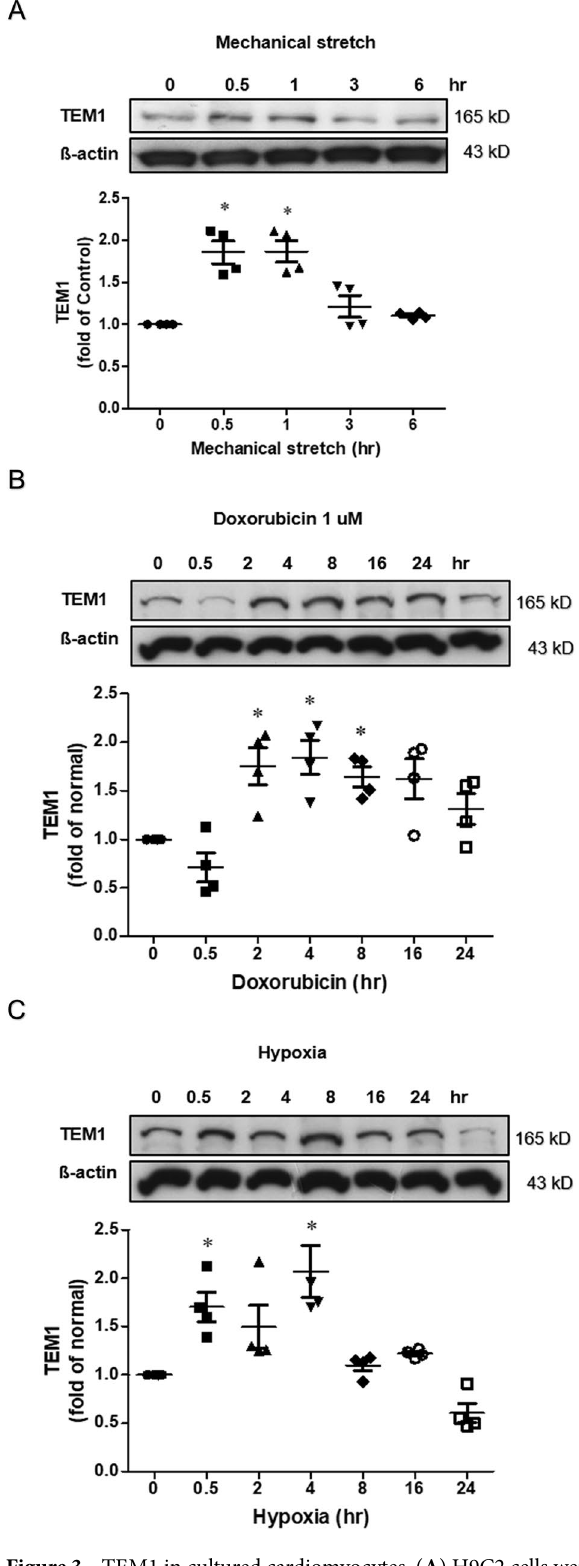
Figure 3. TEM1 in cultured cardiomyocytes. ( A ) H9C2 cells were subjected to mechanical stretch for 6 h. ( B ) H9C2 cells received doxorubicin (1 µM) treatment for 24 h. ( C ) H9C2 cells were exposed to hypoxia incubator prefilled with 1% oxygen for 24 h. The expression levels were analyzed by western blot and expressed as a ratio of baseline before stress (n = 4). *p < 0.05, **p < 0.01 and ***p < 0.001 compared to normal without stress. Original images of western blot were provided in “Supplemental